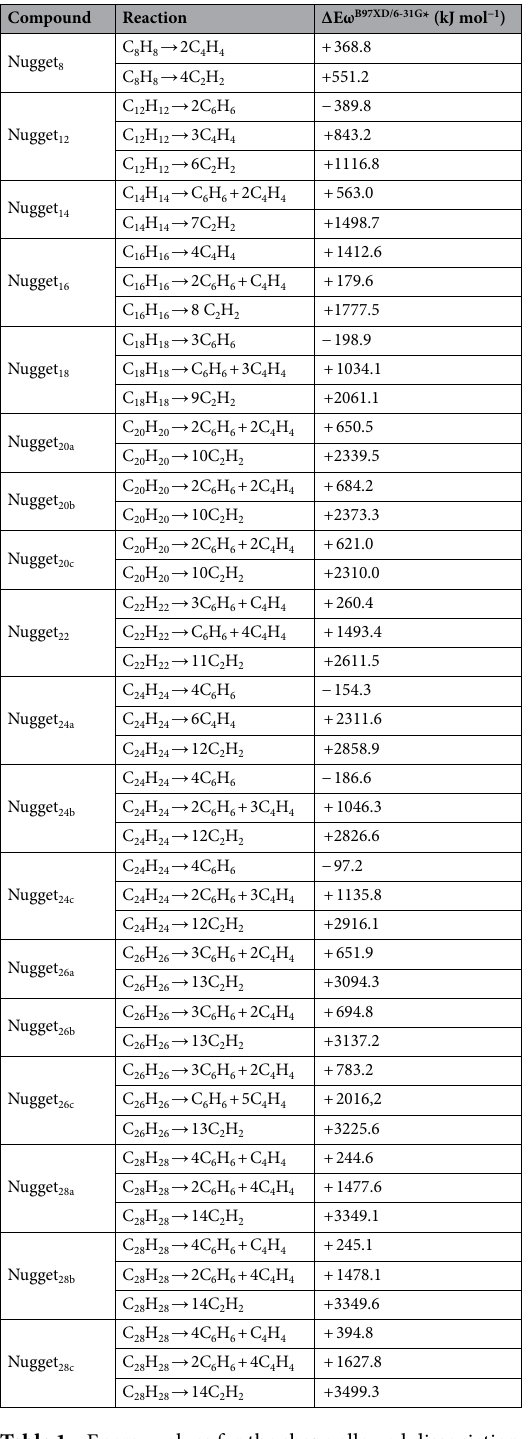
Table 1. Energy values for the shape allowed dissociation reactions of the studied nuggets into either C 6 H 6 and/or C 4 H 4 compounds, or into C 2 H 2 . All values were calculated by the model chemistry ωB97XD/6-31G* . The energy values are given in kJ mol −1 units because they refer to chemical reactions involving one mole of reactant